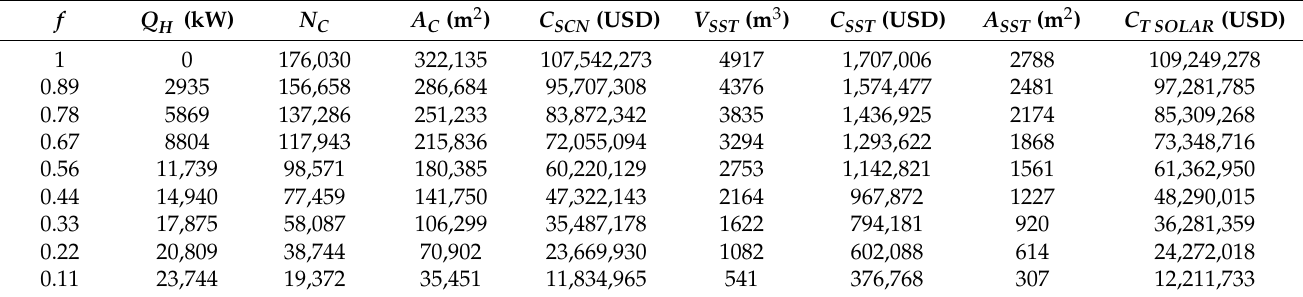
Table 13. Costs of the solar thermal installation to supply the thermal load of an ORC by varying the solar fraction.